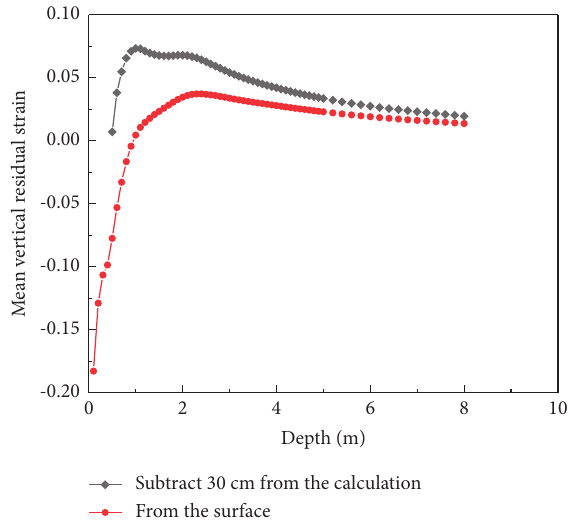
Figure 20: Curve of average vertical residual strain